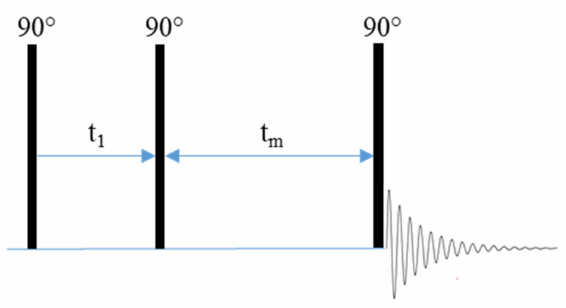
Figure 14. Exchange spectroscopy (EXSY) pulse